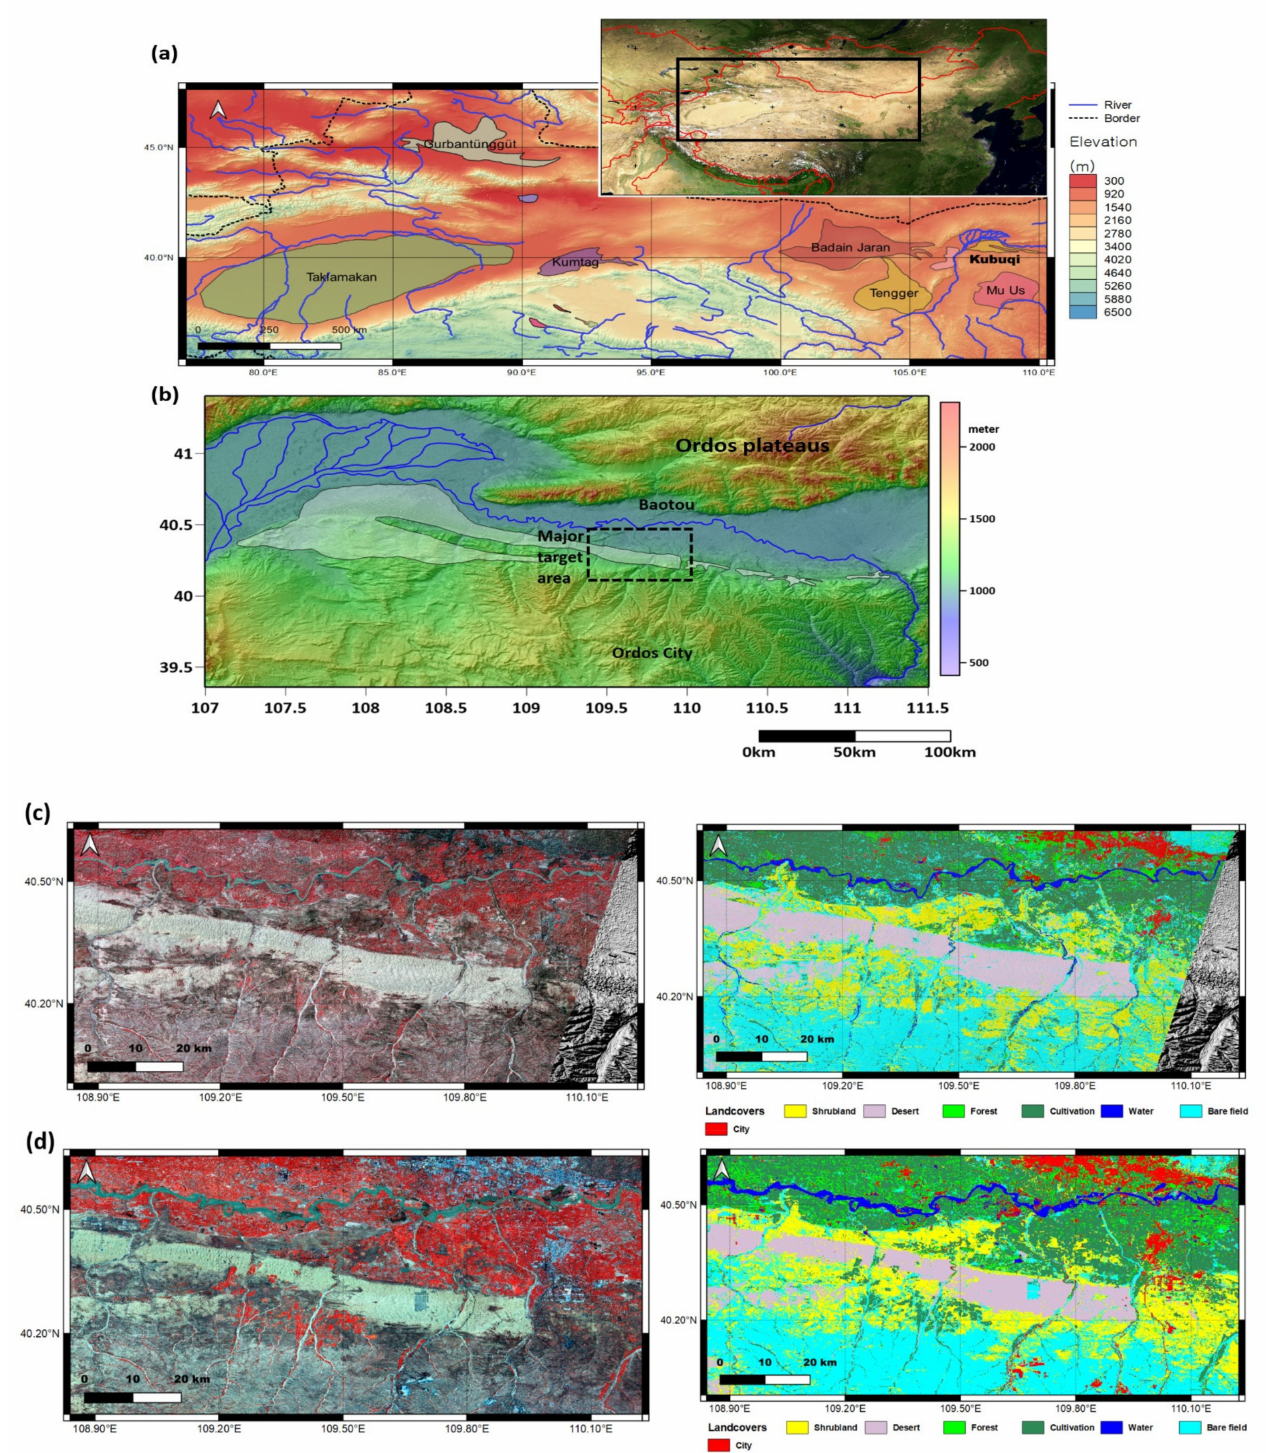
Figure 1. ( a ) North-Eastern deserts in China. Kubuqi is located on the eastern side. ( b ) Location and geological context of the target area over Kubuqi. ( c ) 17 July 2007 (Near-IR-G-B) LANDSAT-5 image and land cover classification. ( d ) 12 September 2019 (Near-IR-G-B) Sentinel-2 multispectral image and the associated land cover classification. Land cover classification was performed by a maximum likelihood algorithm. The changes in land cover around desert areas were noticed. The land cover classification results were employed in the aeolian erosion rate (AER) extraction process (see Section